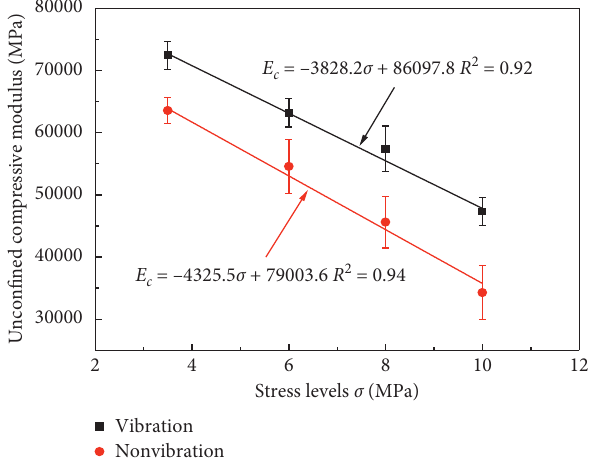
Figure 8: Unconfined compressive modulus of cement-treated aggregates affected by stress